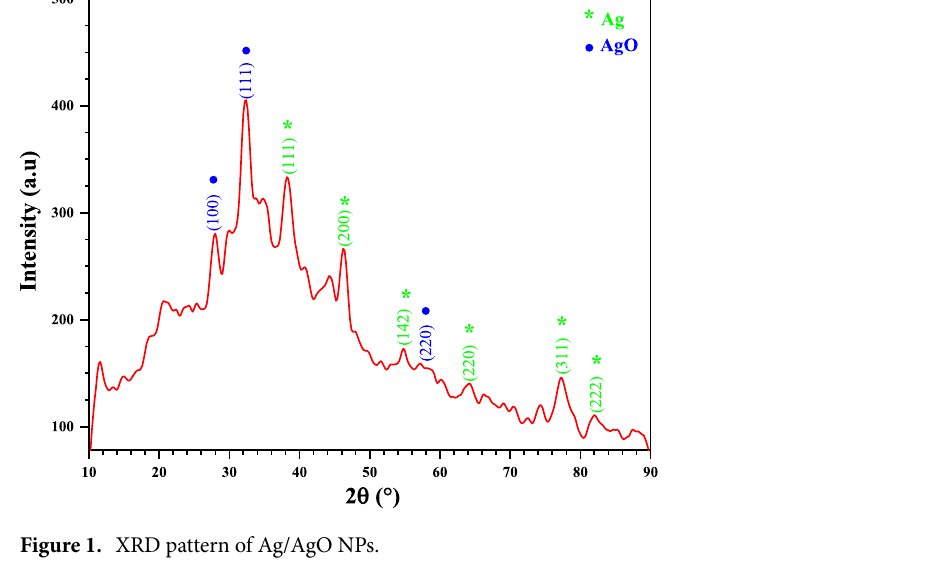
Figure 1. XRD pattern of Ag/AgO NPs.